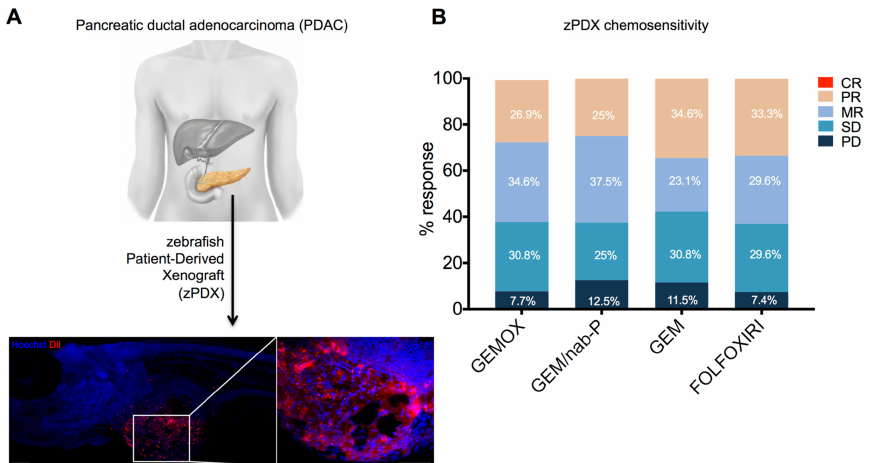
Figure 1. Zebrafish patient-derived xenograft model and type of response to chemotherapy drugs.